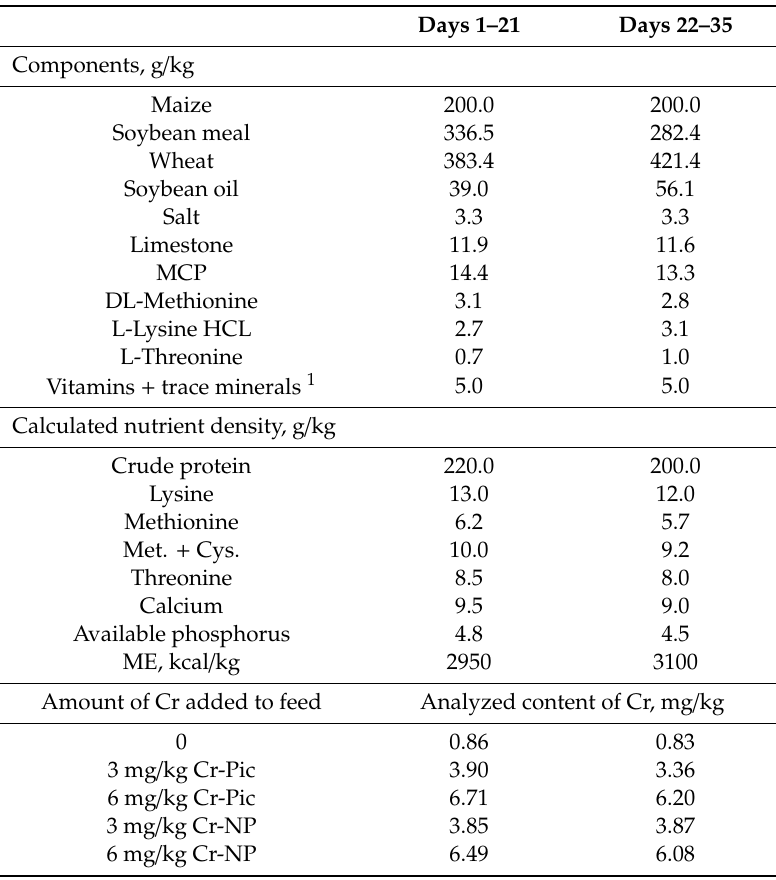
Table 1. Composition and nutrient density of the